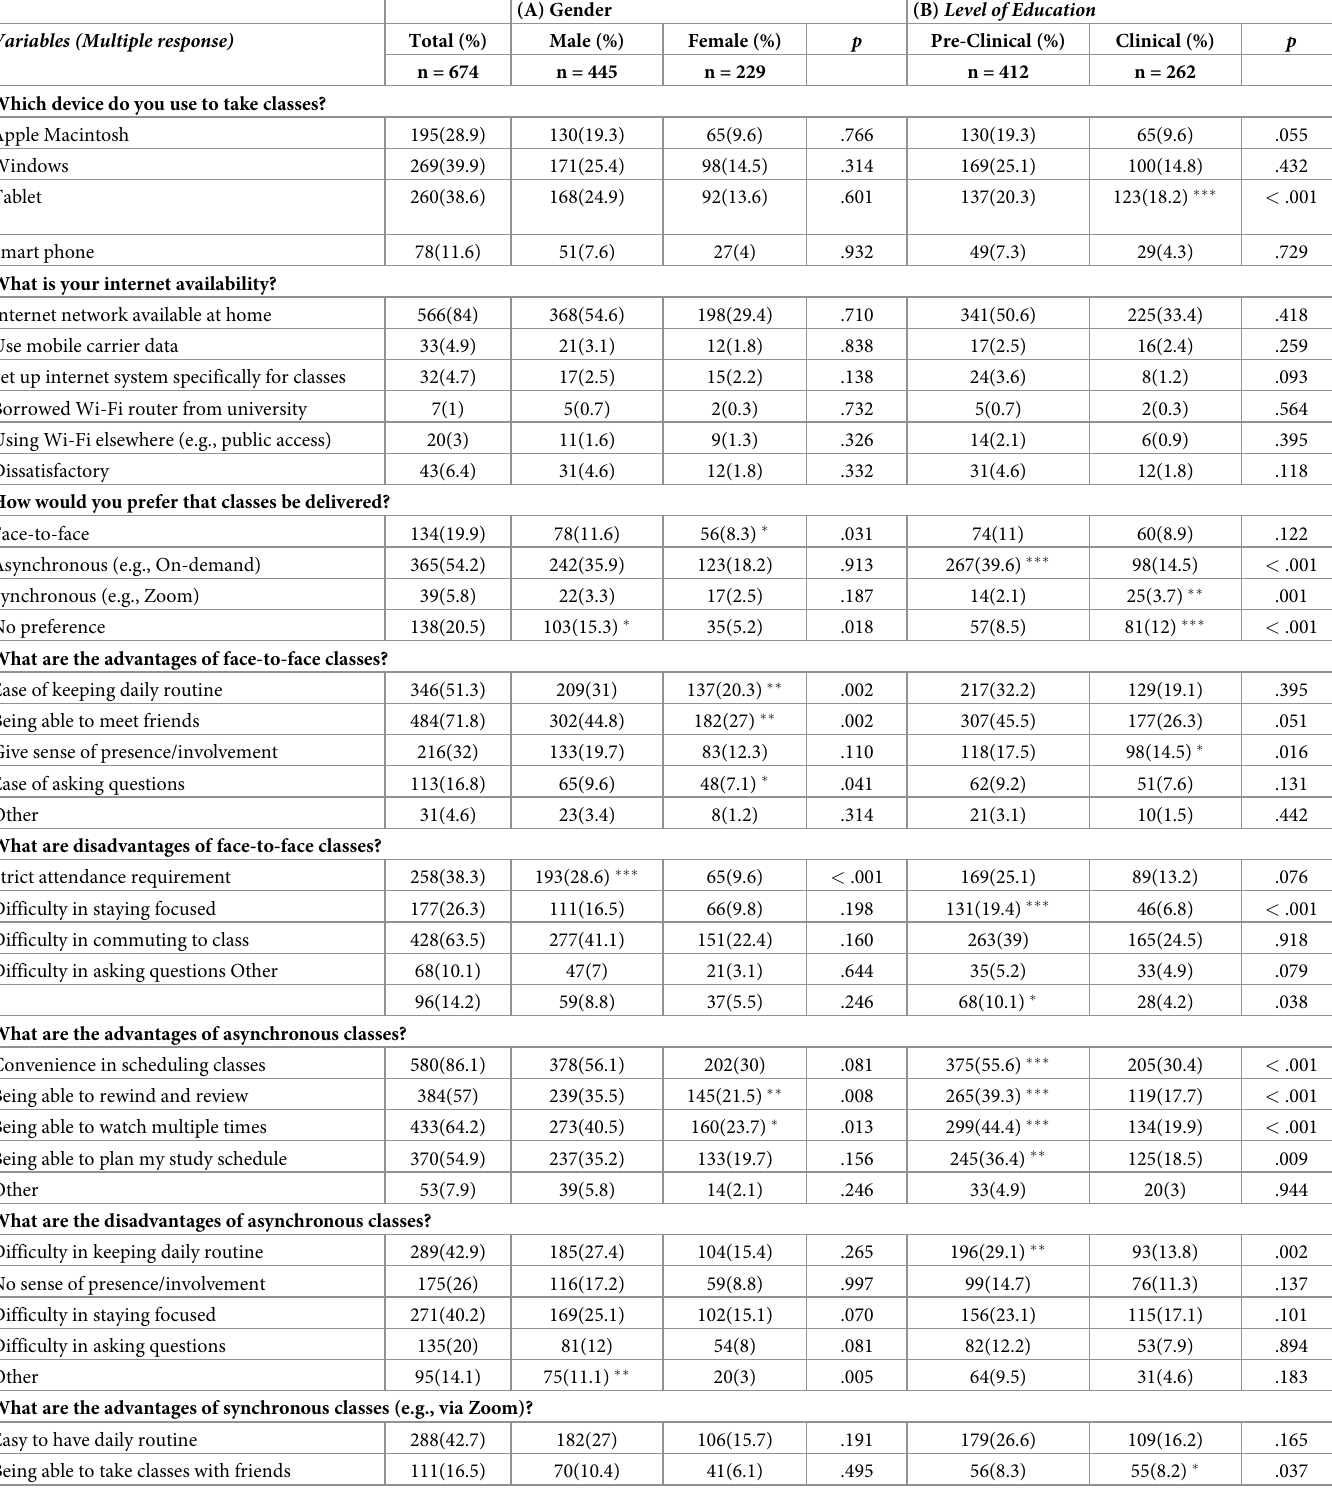
Table 2. Internet accessibility, device usage, and attitude toward online classes during the COVID-19